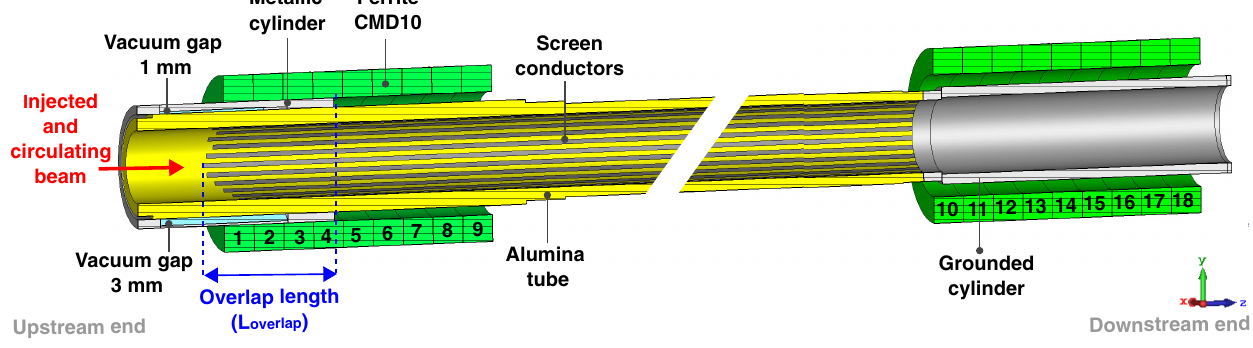
FIG. 3. A CST model of the upstream (left) and downstream (right) end of the conventional beam screen initially developed for the FCC-hh injection kicker